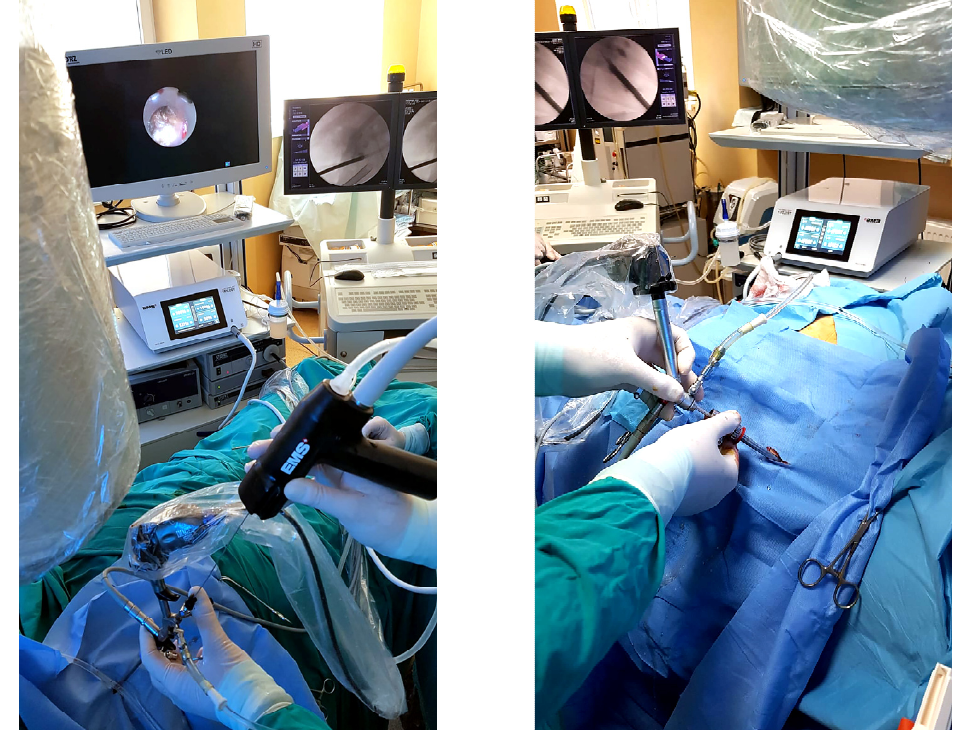
Figure 1. Intraoperative aspects of the Trilogy device.